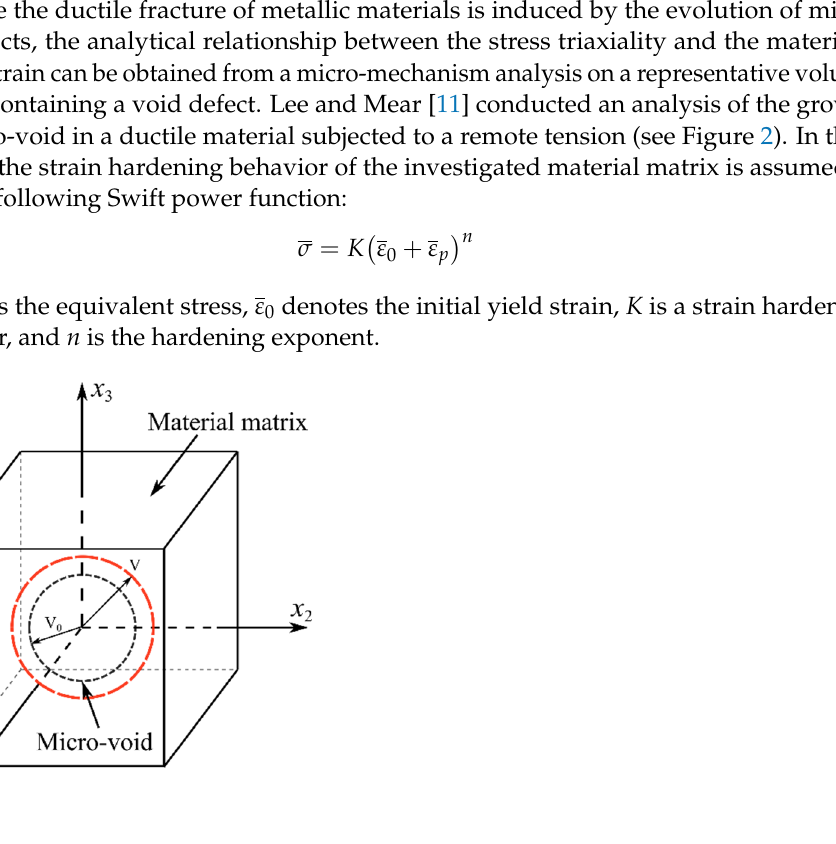
Figure 2. Illustration of a representative element containing a spherical void defect. Remote tensile load is applied along the axis X 3 .